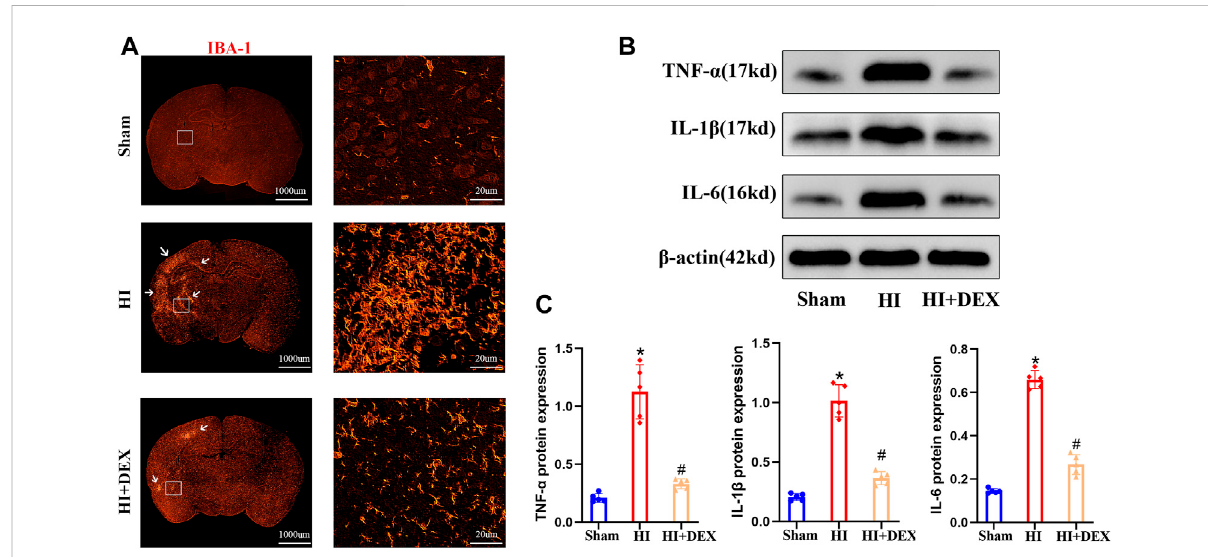
FIGURE 5 DEX reduced in fl ammatory factor protein expression and inhibited microglial activation in neonatal rats with HIBD. (A) Representative IF image (magni fi cation×1,scalebar:1000 μ m;magni fi cation×800,scalebar:20 μ m)showingthelevelsofmicroglialactivationinthesham,HIandHI+DEX groups on D2. (B – C) Representative western blot image and quantitative analysis of the western blot (bar chart) illustrating the protein levels of crucial in fl ammatory factors, including TNF- α , IL-1 β and IL-6, on D2. DEX, Dexmedetomidine; HIBD, Hypoxic-ischemic brain damage; IF, Immuno fl uorescence; HI, Hypoxic-ischemia; D2, 2 days after HIBD. Data are expressed as the mean ± SD ( n = 5 per group). * p < 0.05 vs. the sham group; # p < 0.05 vs. the HI